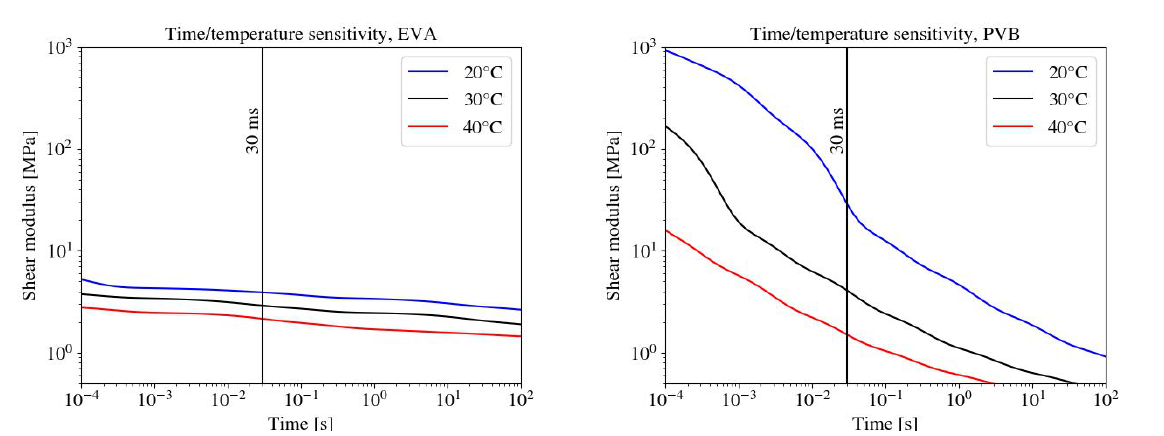
Fig. 10 Shear modulus of EVA and PVB interlayer in the time domain for two different